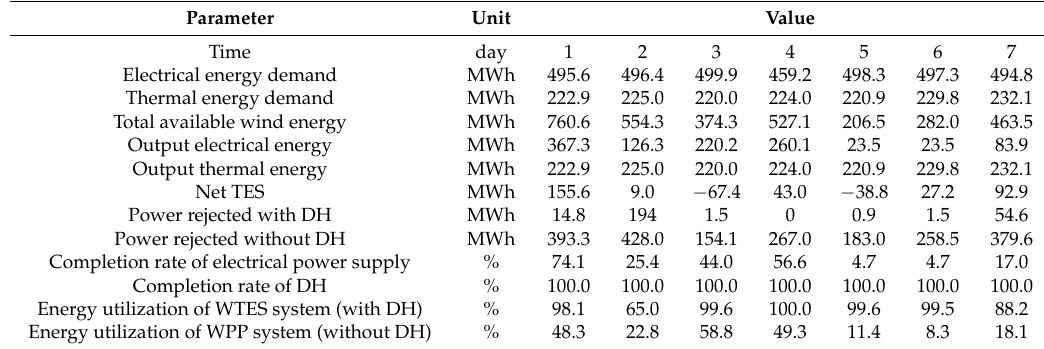
Table 3. Simulating results of the seven-day operation performance.